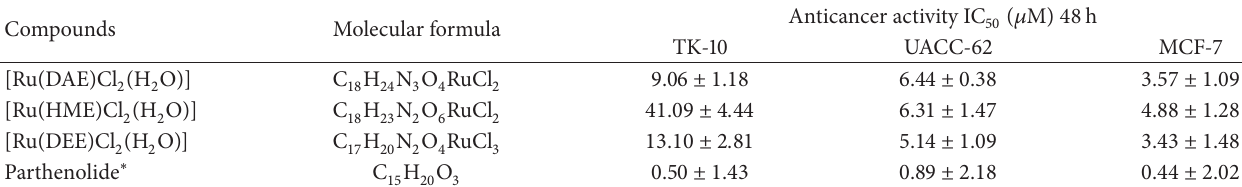
Table 1: In vitro antiproliferative studies of Ru(III)-Schiff base complexes against TK-10, UACC-62, and MCF-7 cell lines. Compounds